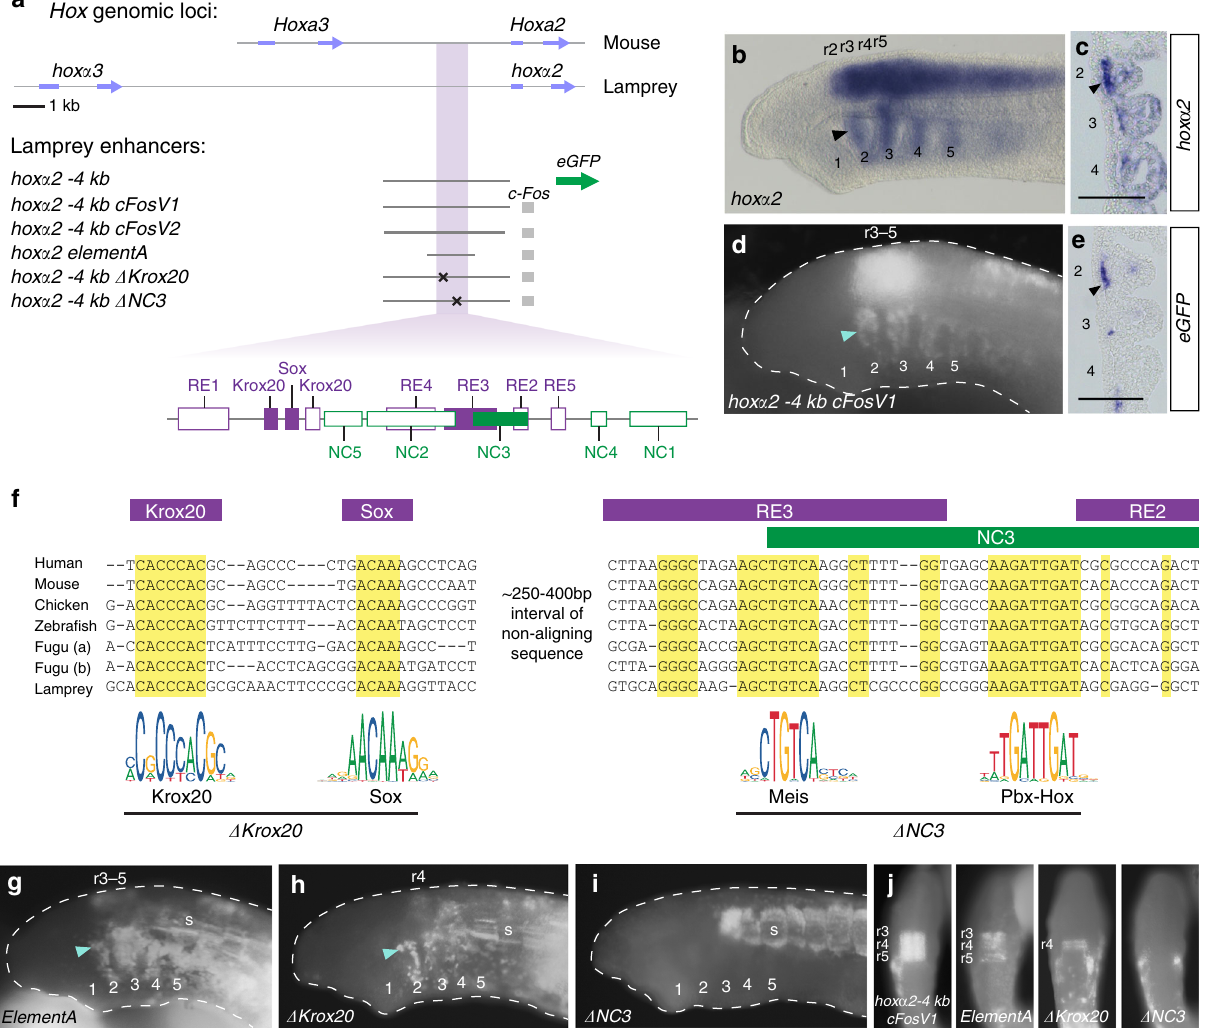
Fig. 4 Characterization of a lamprey hox α 2 neural crest (NC)/hindbrain enhancer. a The mouse Hoxa2 - Hoxa3 genomic region and its equivalent from the lamprey hox α cluster are shown, with Hox gene exons annotated (blue arrows). hox α 2 upstream regions assayed for reporter activity in this study, with or without the c-Fos minimal promoter, are shown. b – e Lateral views ( b , d ) and frontal sections ( c , e ) of st24.5 lamprey embryos, comparing endogenous expression of hox α 2 ( b , c ) to GFP reporter expression mediated by hox α 2 − 4 kb ( d , e ). Pharyngeal arches are numbered and rhombomeric expression detailed. Arrowheads point to PA2 NC expression. f Multiple sequence alignment of the Hoxa2 NC enhancer from gnathostomes with the lamprey hox α 2 enhancer, showing conserved sites (yellow). The positions of characterized mouse cis -elements ( Krox20 , Sox , RE2-3 , NC3 ) are marked above the alignment. The enhancer schematic ( a ) shows the position of these elements within the assayed hox α 2 upstream regions, with conserved (shaded boxes) or divergent (empty boxes) cis -elements highlighted. Consensus binding motifs from the JASPAR database 76 for Krox20 77 , Sox11 78 , Meis1 79 , and Pbx-Hox 80 factors are shown below the alignment, as well as sequences deleted in hox α 2 − 4 kb Δ Krox20 and Δ NC3 variants. The non-aligning interval between these conserved regions is ~250 – 400 bp and varies in length between species. Supplementary Figure 5 contains the full alignment. g – j Lateral ( g - i ) and dorsal ( j ) views of st24.5 lamprey embryos showing GFP reporter expression driven by the enhancers detailed in a . Pharyngeal arches are numbered, with expression in rhombomeres (r) and somites (s) annotated. GFP-expressing embryos shown are representative of the expression potential of the reporter construct in each case, as inferred from screening many (typically more than 100) injected embryos. Supplementary Table 2 provides the number of embryos and details of speci fi c expression for all constructs in